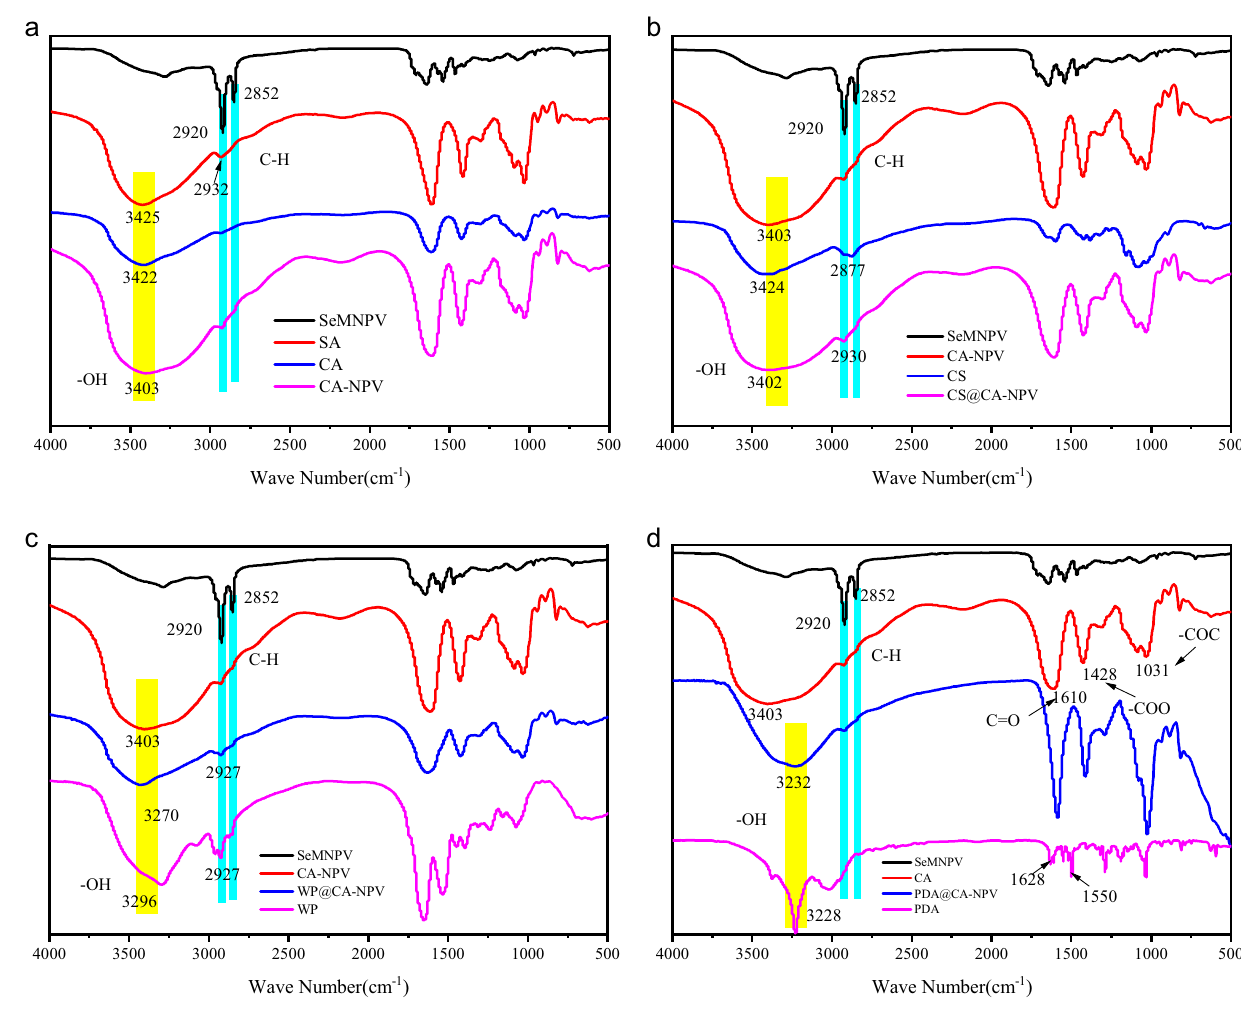
Figure 2. IR spectra of SeMNPV, CA-NPV, CS@CA-NPV, WP@CA-NPV, PDA@CA-NPV, and their raw materials. IR spectra of the samples were obtained on a Spectrum-100 instrument, using the KBr pellet method, in the spectral wavelength’s range of 4000–500 cm −1 . An abundance of hydroxyl groups were represented at 3000–3500 cm −1 . SeMNPV produced two distinct bands at 2920 cm −1 and 2852 cm −1 , which correspond to the asymmetric and symmetric stretching vibrations of methylene C–H, respectively. In Fig. 2d, the absorption bands at 1520, 1615, and 3420 cm −1 corresponded to the shearing vibration of N–H in the amide group, aromatic rings, and the –OH groups in catechol, respectively. The PDA@CA-NPV produced the absorbance peaks at 1610, 1428 and 1031 cm −1 were attributed to C=O stretching vibrations. asymmetric vibrations of – COO, and alkyl C–O–C deformation vibrations of